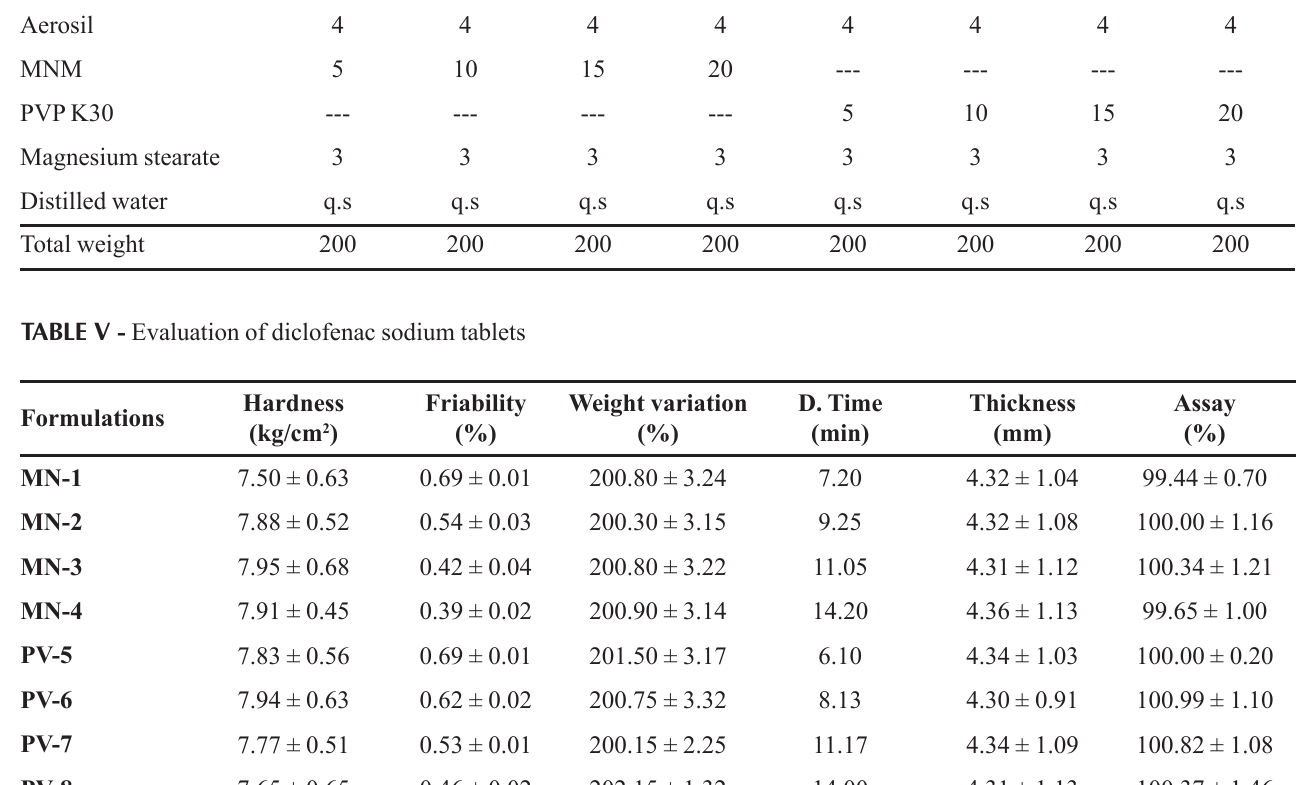
TABLE IV - Formulation of diclofenac sodium tablets by wet granulation method Ingredients (mg)